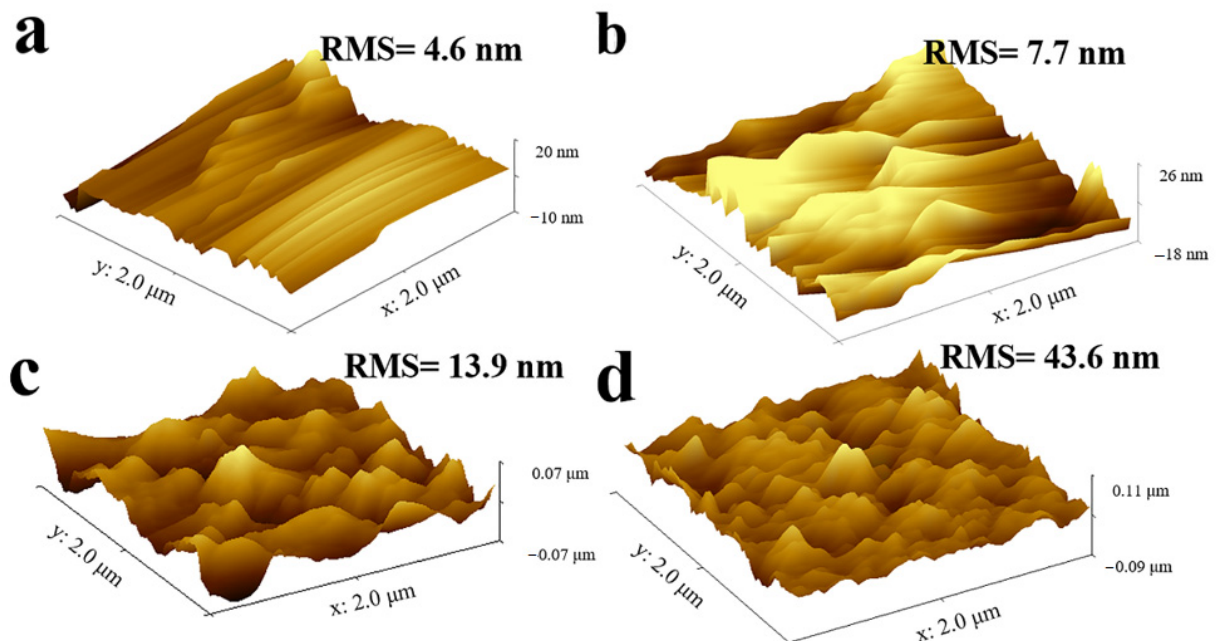
Figure 3. Atomic force microscopy (AFM) images of the fabrics: ( a ) pristine fabric, ( b ) PDMS-coated fabric, ( c ) PDMS/STA- coated fabric, and ( d ) PDMS/STA/SiO 2 -coated fabric.